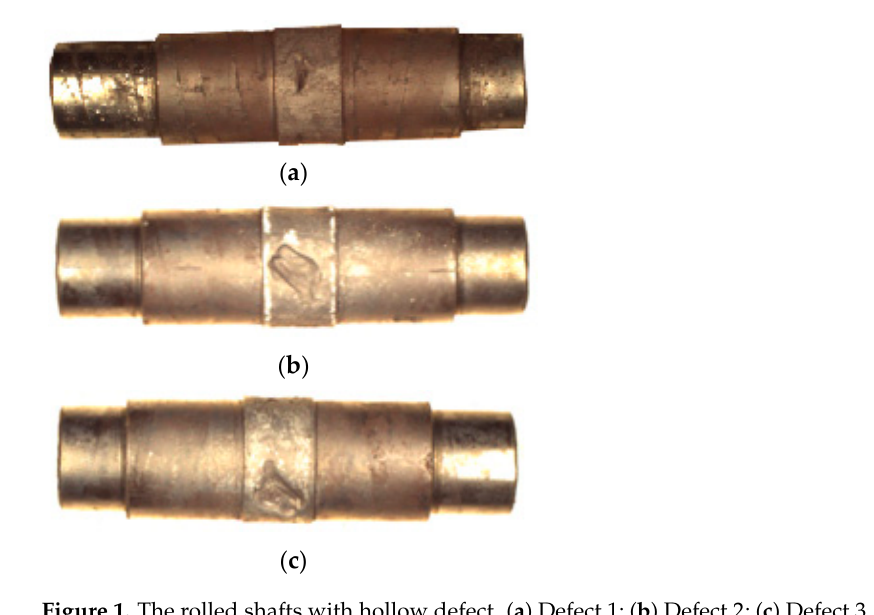
Figure 1. The rolled shafts with hollow defect. ( a ) Defect 1; ( b ) Defect 2; ( c ) Defect 3.